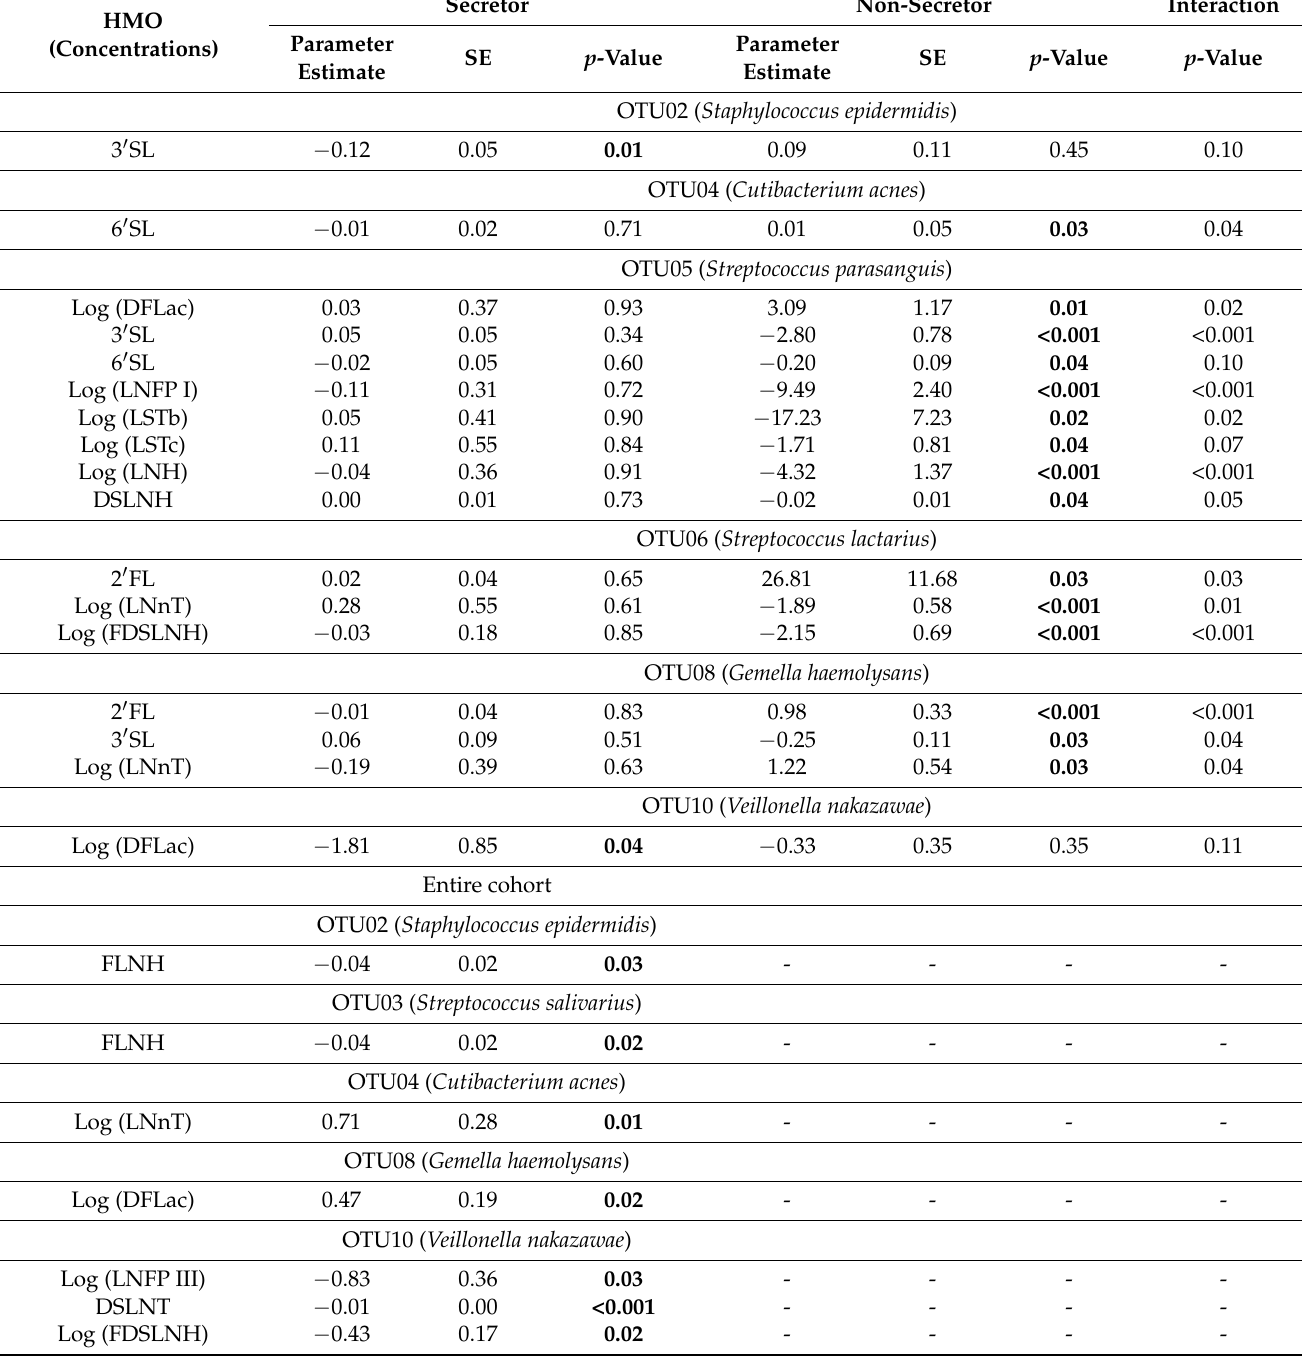
Table 4. Associations between individual HMO concentrations and bacterial OTUs at two months